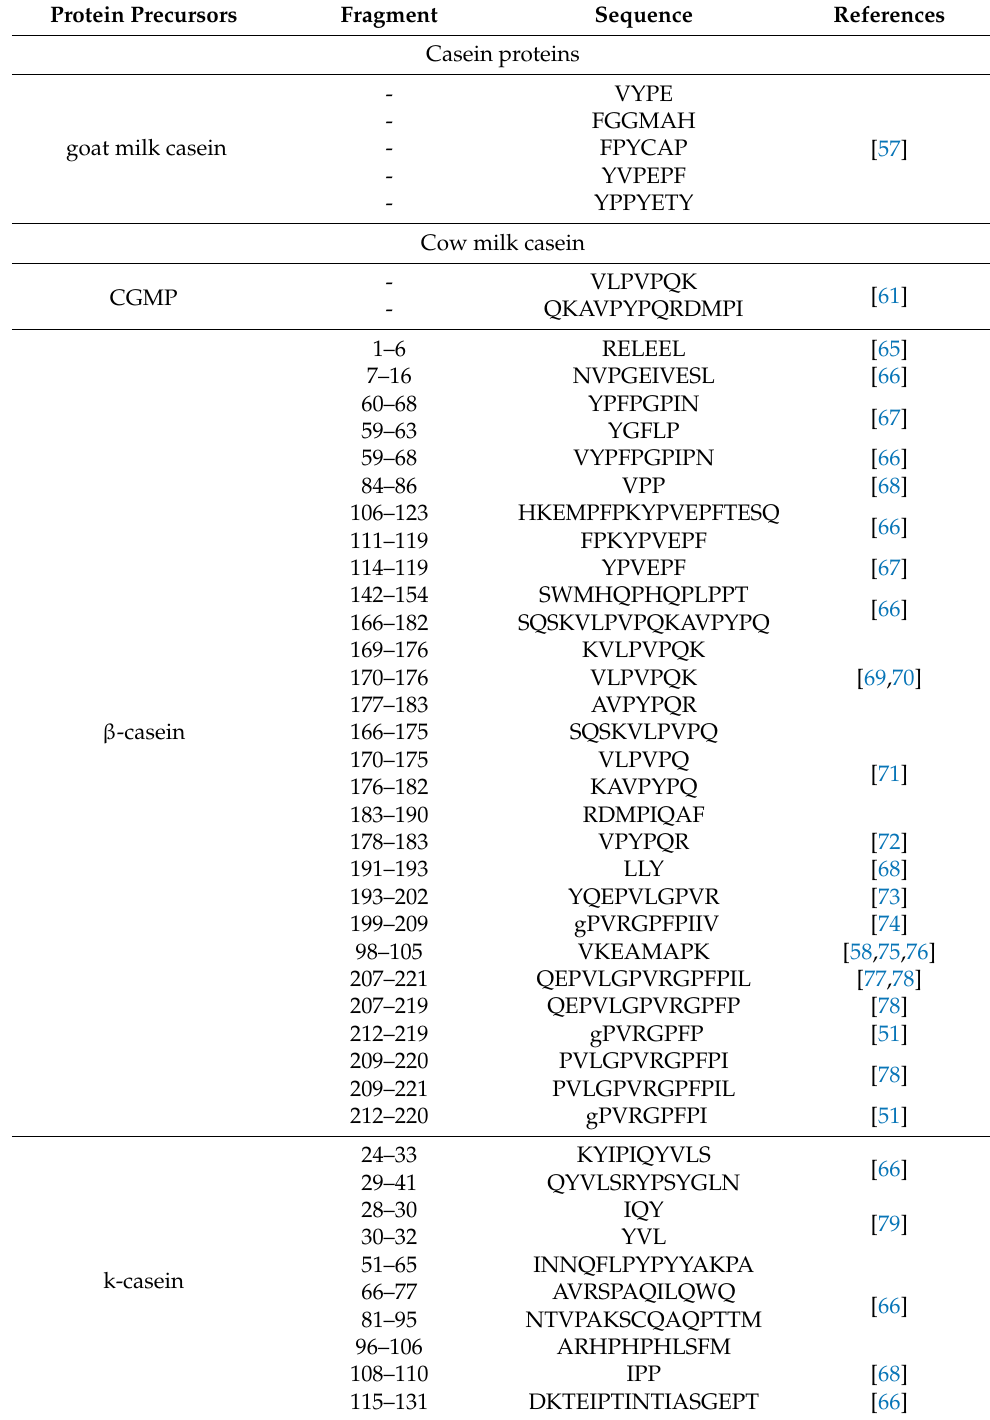
Table 1. Biologically active peptides with antioxidant properties (own work based on: [51,54,57,58,61,65–92]). Protein